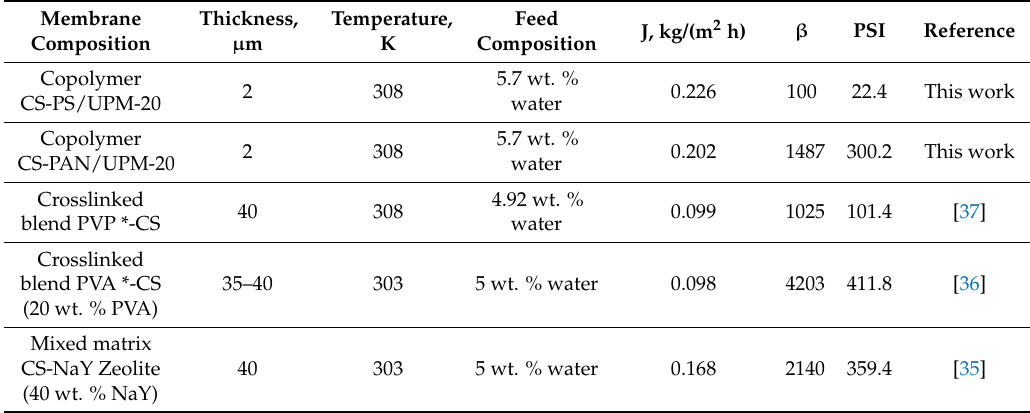
Table 7. Comparison of pervaporation performance of CS-based membranes in THF pervaporation dehydration